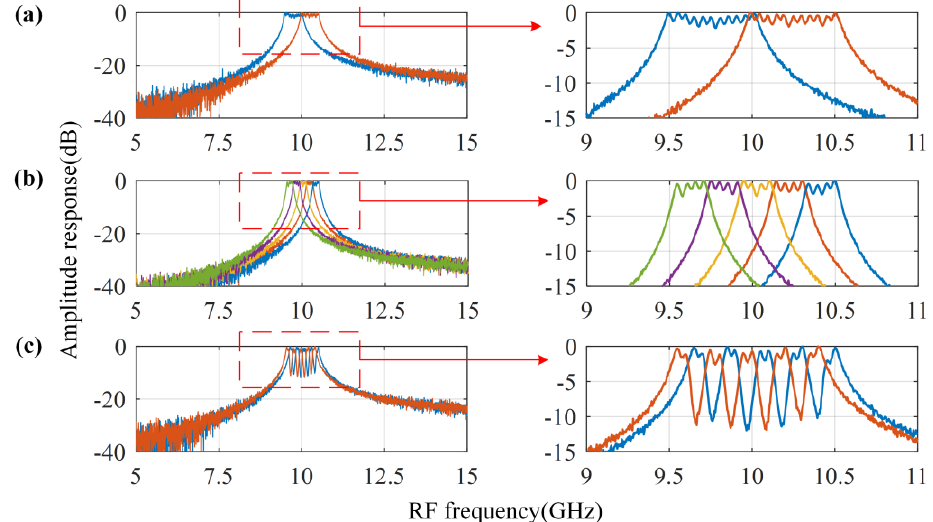
Figure 5. ( a ) The frequency response of the RF FSS when two ports are used and each outputs five RF channels. ( b ) Five ports are used and the RF FSS outputs two RF channels in every port. ( c ) The RF FSS is set as an interleaver.